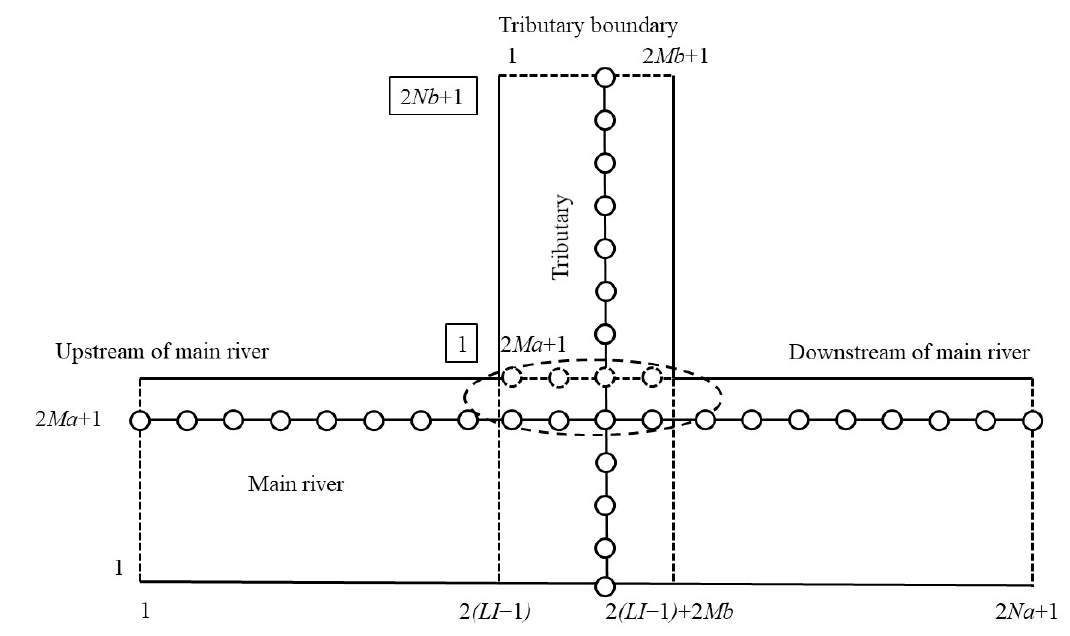
Figure 4. Detail of river intersection generalization.